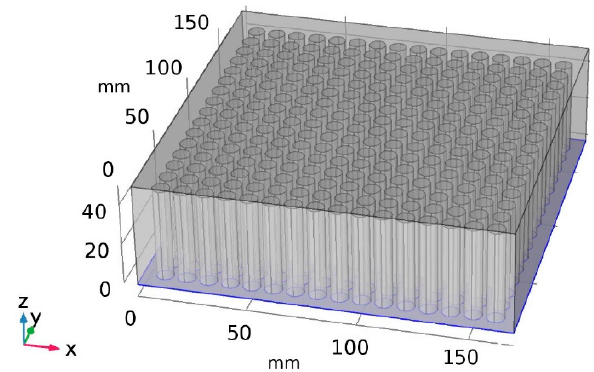
Figure 2. The plexiglass slab used to simulate tile with porous cells inside.